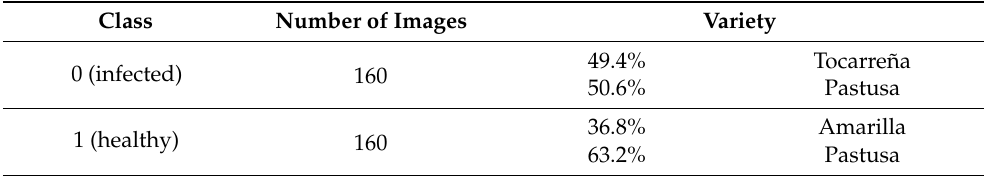
Table 1. Classification and total number of sheets that make up the data set.